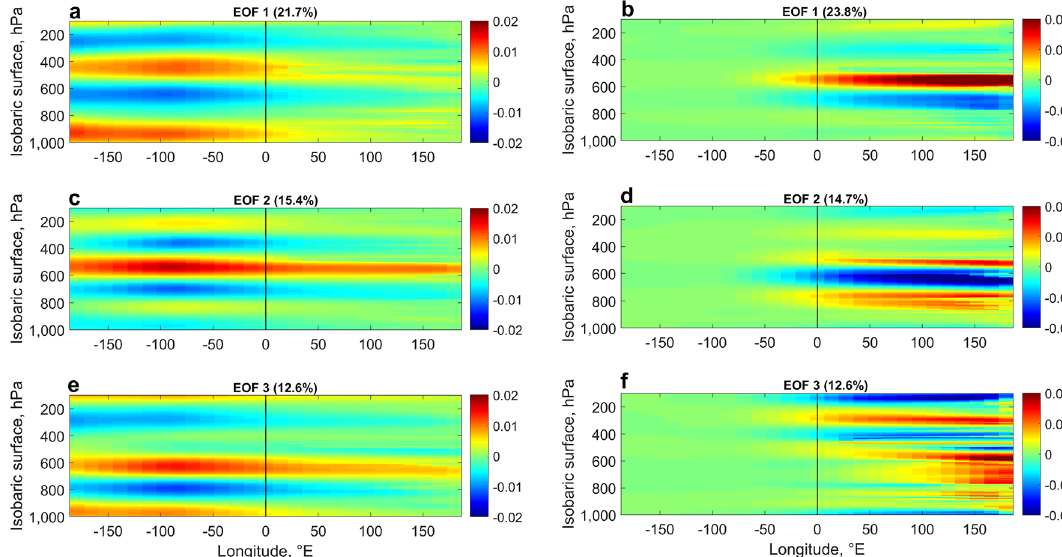
Figure 2. Empirical orthogonal functions (EOFs) of the sensible (left) and latent (right) heat transport components (SHT and LHT). ( a ) First EOF for the SHT ( 21.7% ). ( b ) First EOF for the LHT ( 23.8% ). ( c ) Second EOF for the SHT ( 15.4% ). ( d ) Second EOF for the LHT ( 14.7% ). ( e ) Third EOF for the SHT ( 12.6% ). ( f ) Third EOF for the LHT ( 12.6% ). The reference lines are drawn at the prime meridian 0°. The values in the